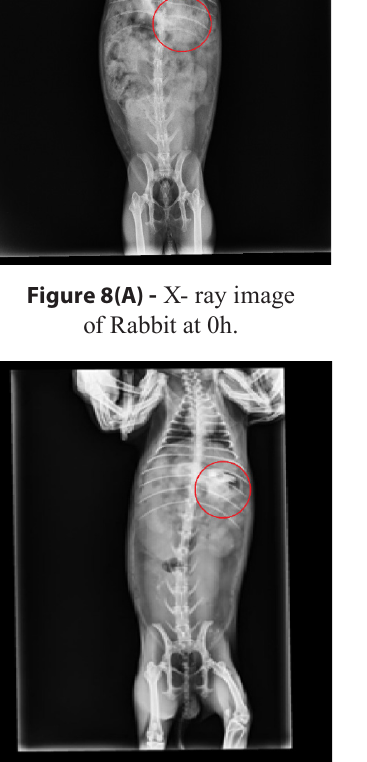
Figure 8(D) - X-ray image of Rabbit at 3h.